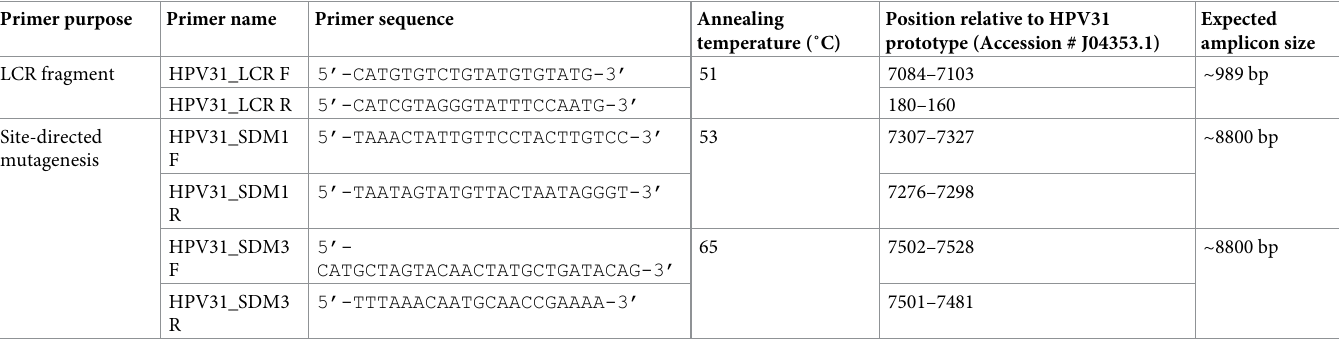
Table 1. Properties of primers to amplify HPV31 LCR and to conduct site-directed mutagenesis on the reporter plasmid. Primer